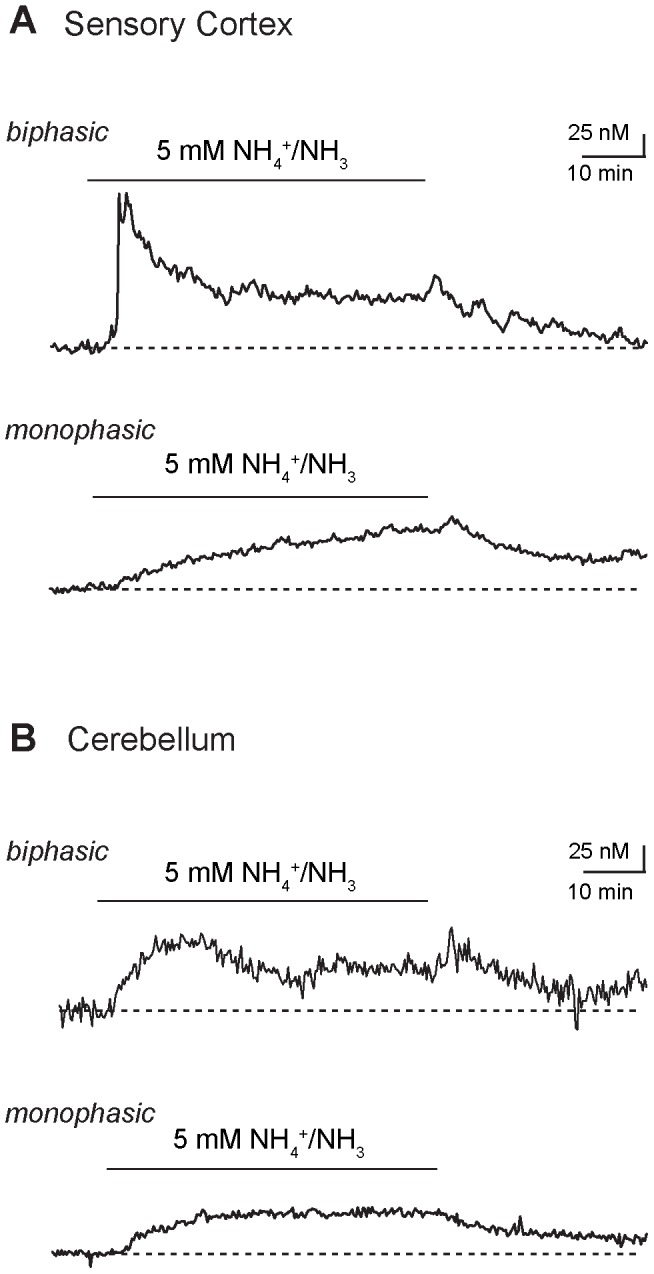
NH4
+-induced changes in neocortex and cerebellum.
(A) Calcium changes evoked by bath perfusion with 5 mM NH4
+/NH3 for 30 minutes (indicated by bar) in two different SR101-positive astrocytes of the sensory cortex. Upper trace: biphasic response, consisting of a transient elevation followed by a plateau phase. Lower trace: monophasic response with a plateau phase only. (B) Calcium changes evoked by bath perfusion with 5 mM NH4
+/NH3 for 30 minutes (indicated by bar) in two different Bergmann glial cells of the cerebellar cortex. Upper trace: biphasic response, consisting of a transient elevation followed by a plateau phase. Lower trace: monophasic response with a plateau phase only.